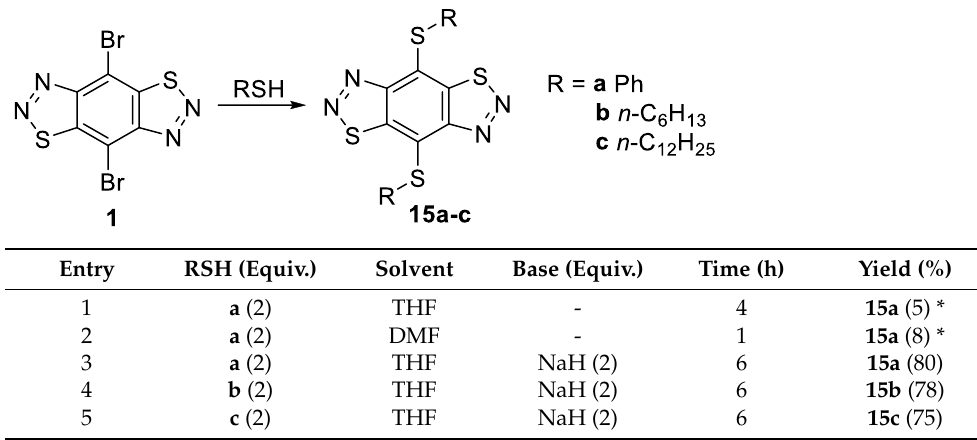
Table 4. Reaction of 4,8-dibromobenzo[1,2- d :4,5- d ’]bis([1,2,3]thiadiazole) 1 with S